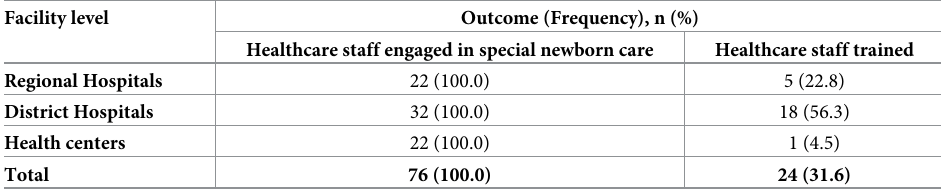
Table 3. Status of health care staff training on in-patient newborn